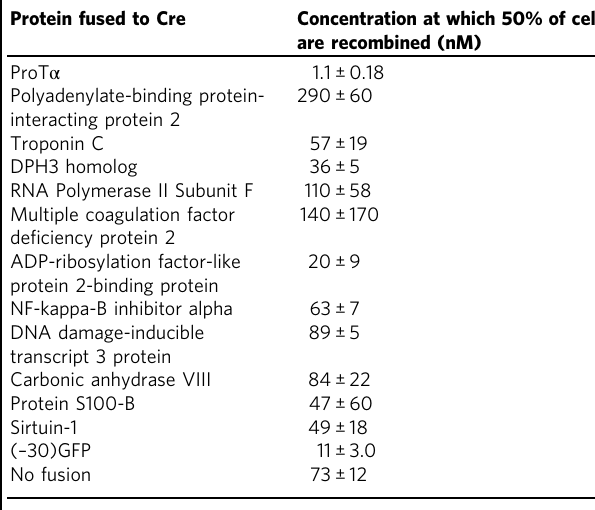
Table 1 Protein delivery using Lipofectamine RNAiMAX in HeLa-DsRed cell